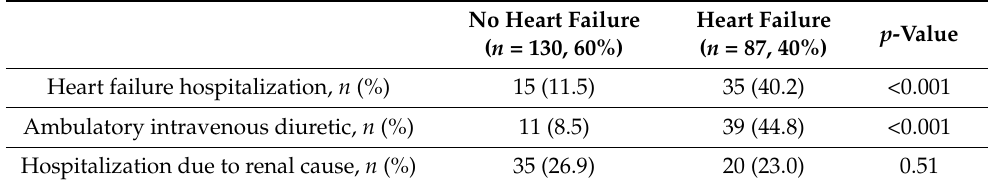
Table 2. Outcomes of patients with heart failure at inclusion compared to those without